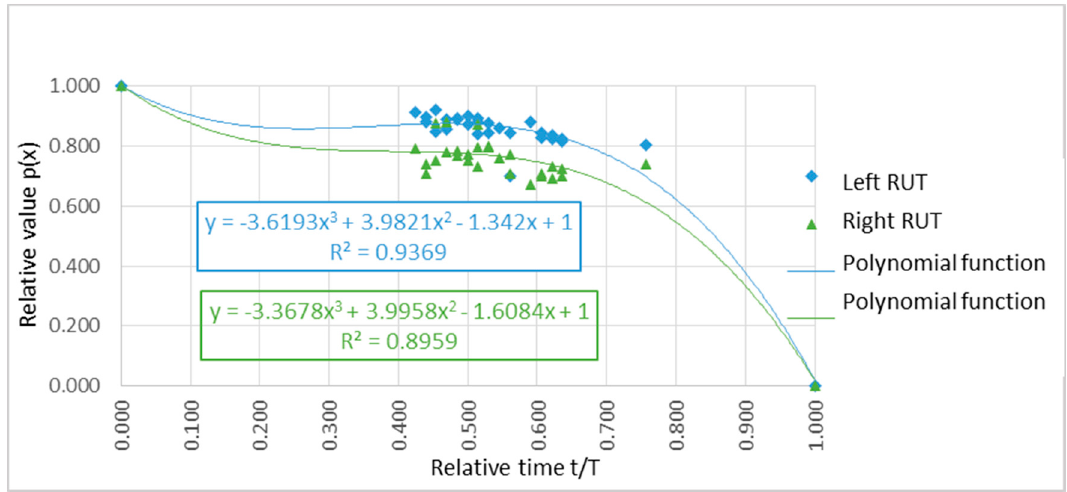
Figure 8. Degradation of the rut depending on the time t/T.